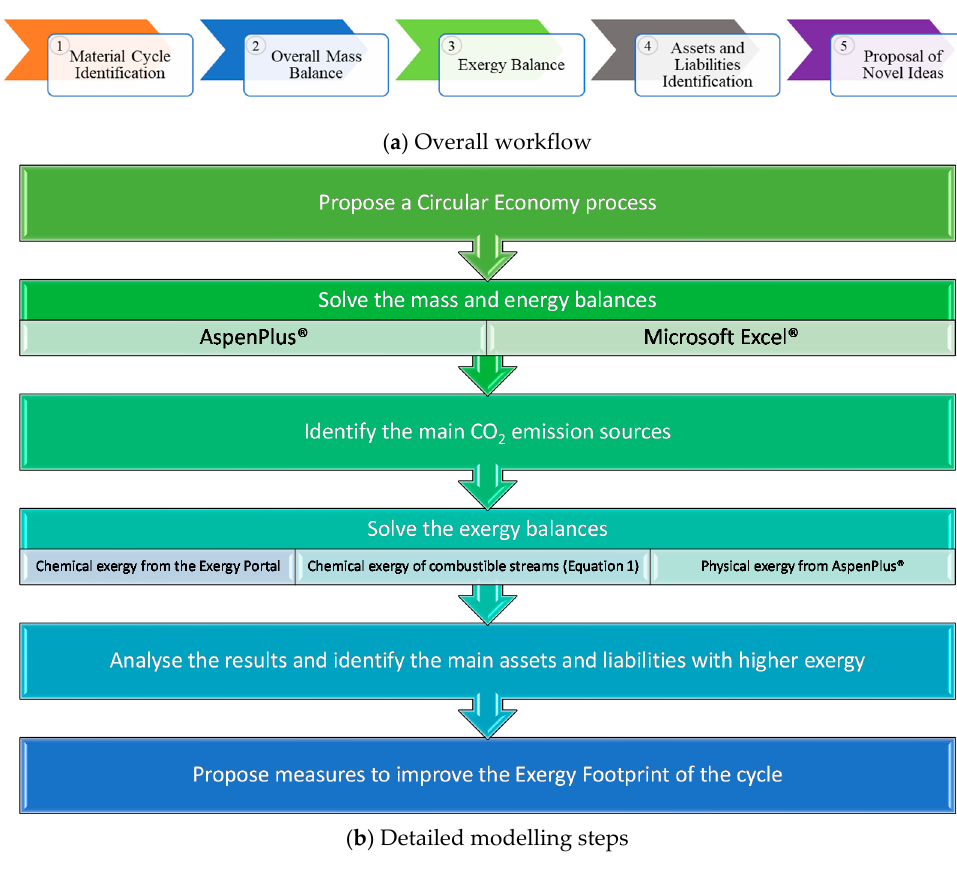
Figure 2. Steps for the exergy assessment.